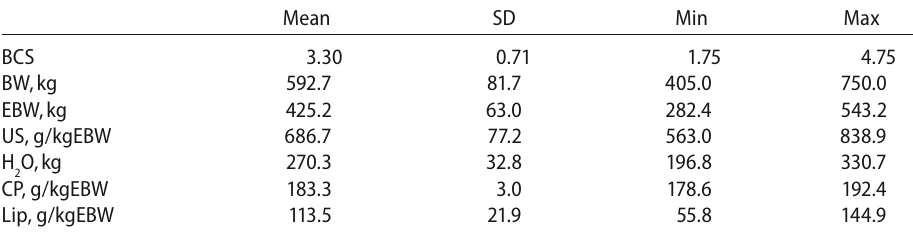
Table 3 presents differences of mean values for above parameters, and also calculated median of differences.